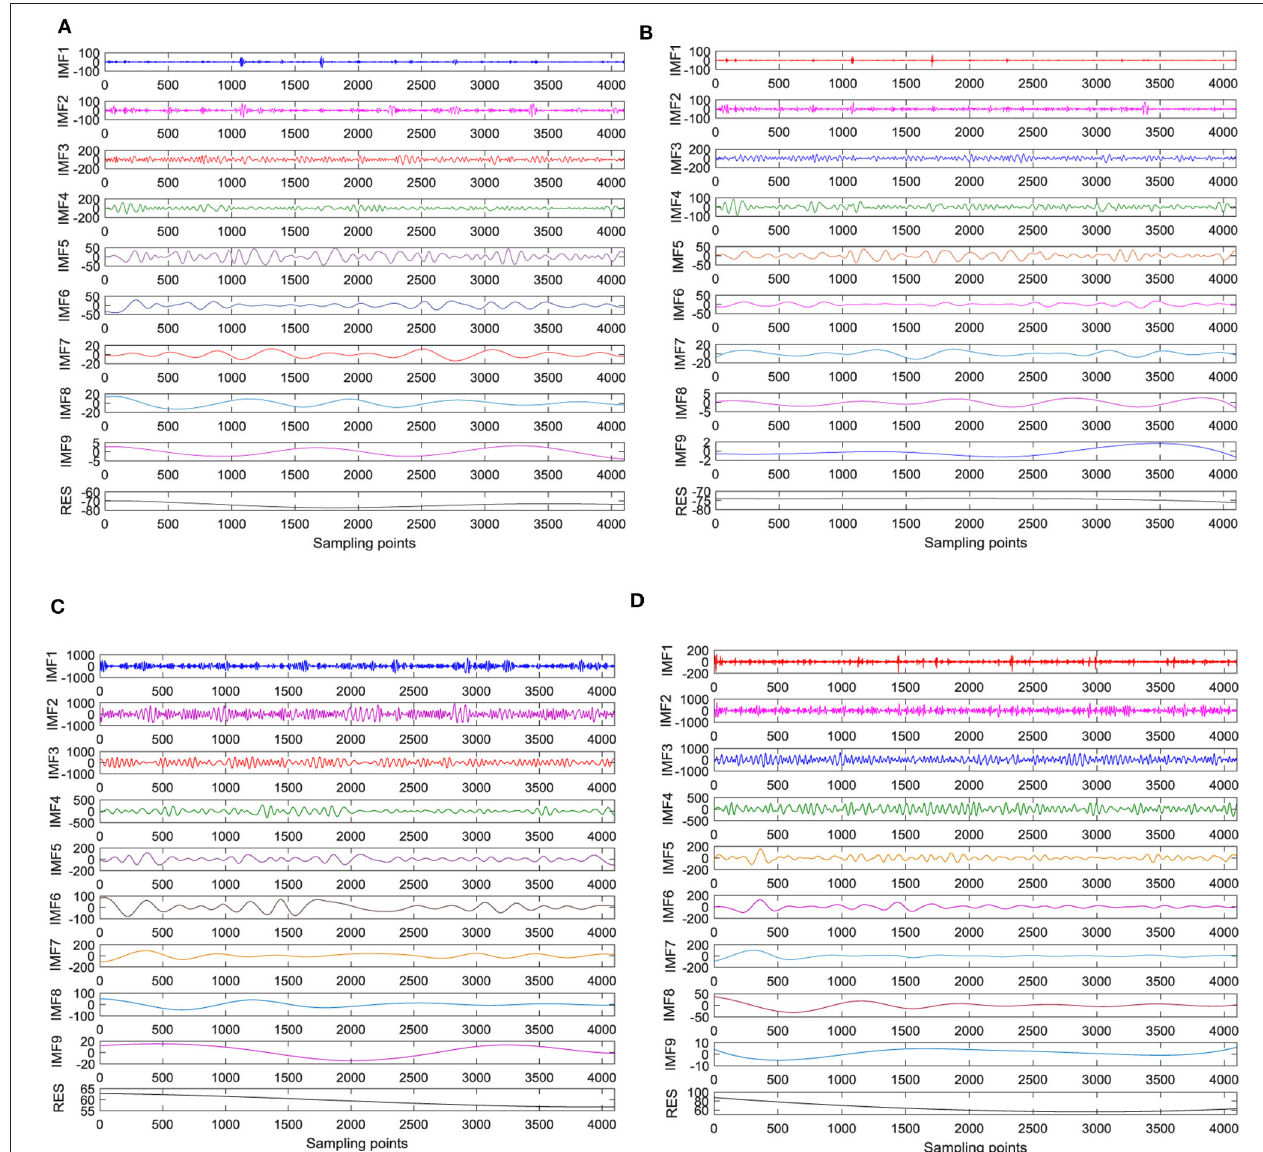
FIGURE 2 | The signal decomposition of EEG between interictal and ictal period. (A) EMD decomposition during the interictal period, (B) CEEMD decomposition during the interictal period, (C) EMD decomposition during the ictal period, and (D) CEEMD decomposition during the ictal